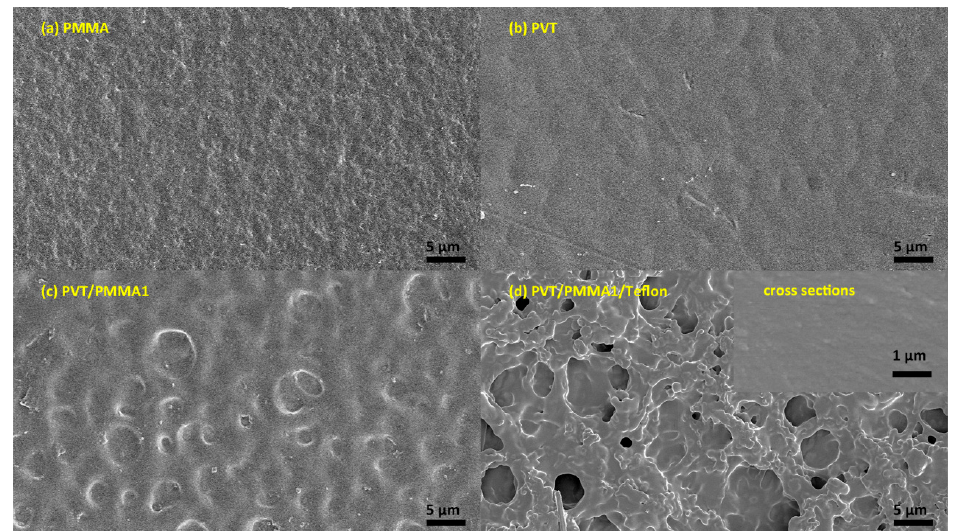
Figure 2. SEM images of ( a ) pristine PMMA film, ( b ) pristine P(VDF-TrFE) (vinylidene fluoride-co-trifluoroethylene) film, ( c ) PVT/PMMA1 blended film, and ( d ) PVT/PMMA1 blended film covered with a layer of Teflon. The inset of ( d ) is the freeze-fractured cross-section of the PVT/PMMA1/Teflon